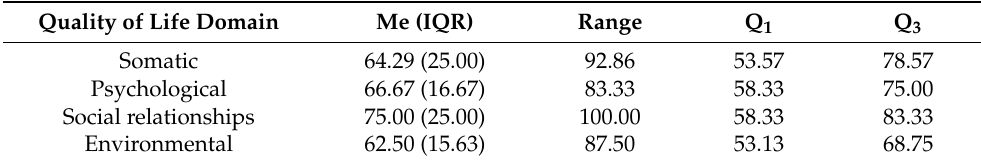
Table 4. Summary of the WHOQOL-BREF domains (score after transformation to the scale of 0–100), ( N = 905).